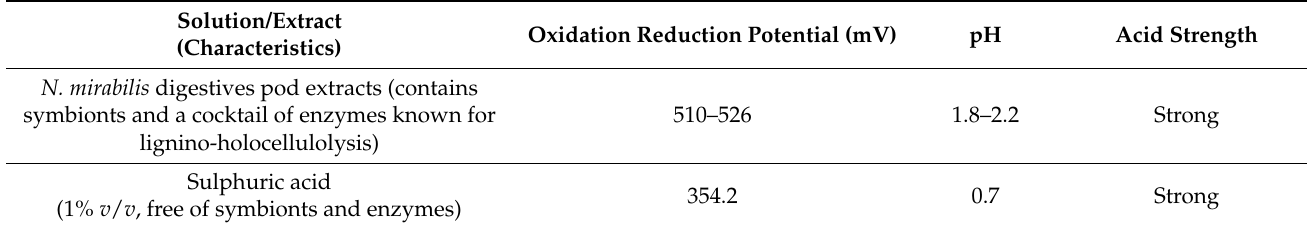
Table 3. Direct comparison of dilute (1% v / v ) sulphuric acid solution (Grauer 1991) to N. mirabilis pod extracts [16,22].